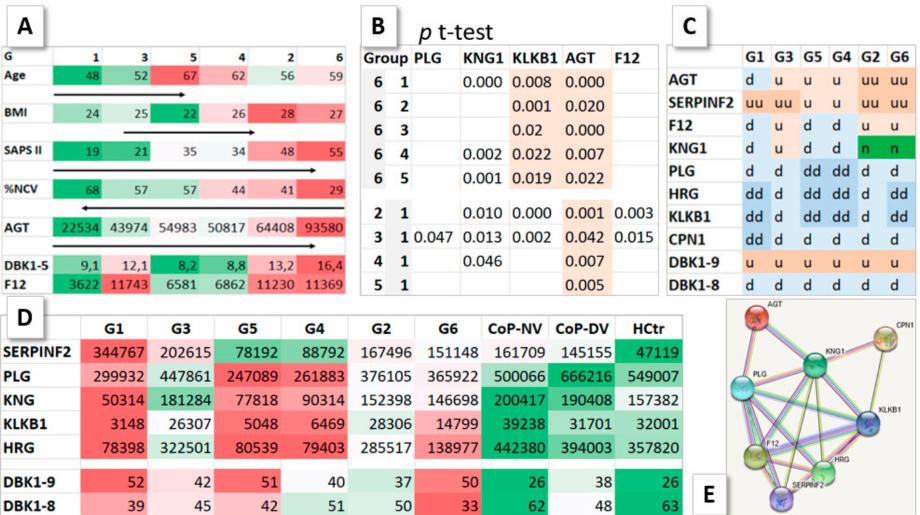
Figure 5. Properties of G1–6. ( A ) Average values for patient parameters (color series: red, worst values; green, best values). In the order G1–G3–G5–G4–G2–G6, the percentages of normal clinical values (%NCV) decreased and SAPS II increased. Average ion intensities for angiotensinogen (AGT) also rose in the series, as did DBK1-5, which additionally showed a second peak in group 3—matching enhanced ion intensities of coagulation factor 12 (F12, Hageman factor) in G3. ( B ) T -test results for significant differences in HDMS ion intensities of selected proteins. The AGT concentration differed between G1 and G6 and all other groups. ( C ) Matrix to visualize concentration differences for selected proteins as determined based on their HDMS ion intensities and the DBK degradation results [2] with respect to HCtr. n, normal; d, downregulated (low values); dd, more downregulated; u, upregulated (high values); uu, more upregulated. U for DBK1-9 means low DBK